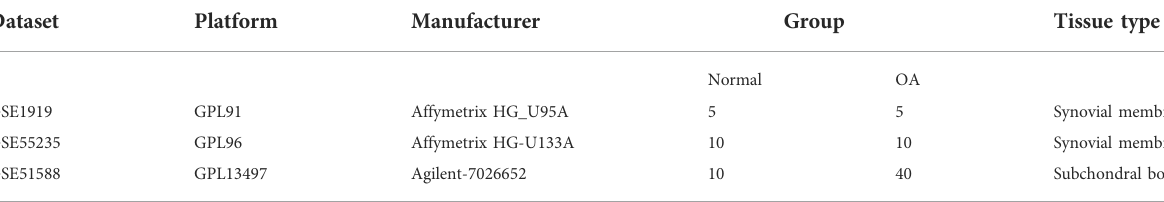
TABLE 1 Information of the GEO